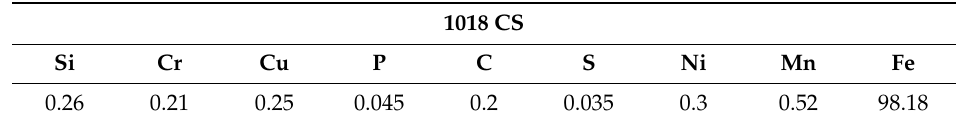
Figure 1. Ninety-Degree elbow specimen. ( a ) As received1018 CS ( b, c ) fine polished axially cut section.